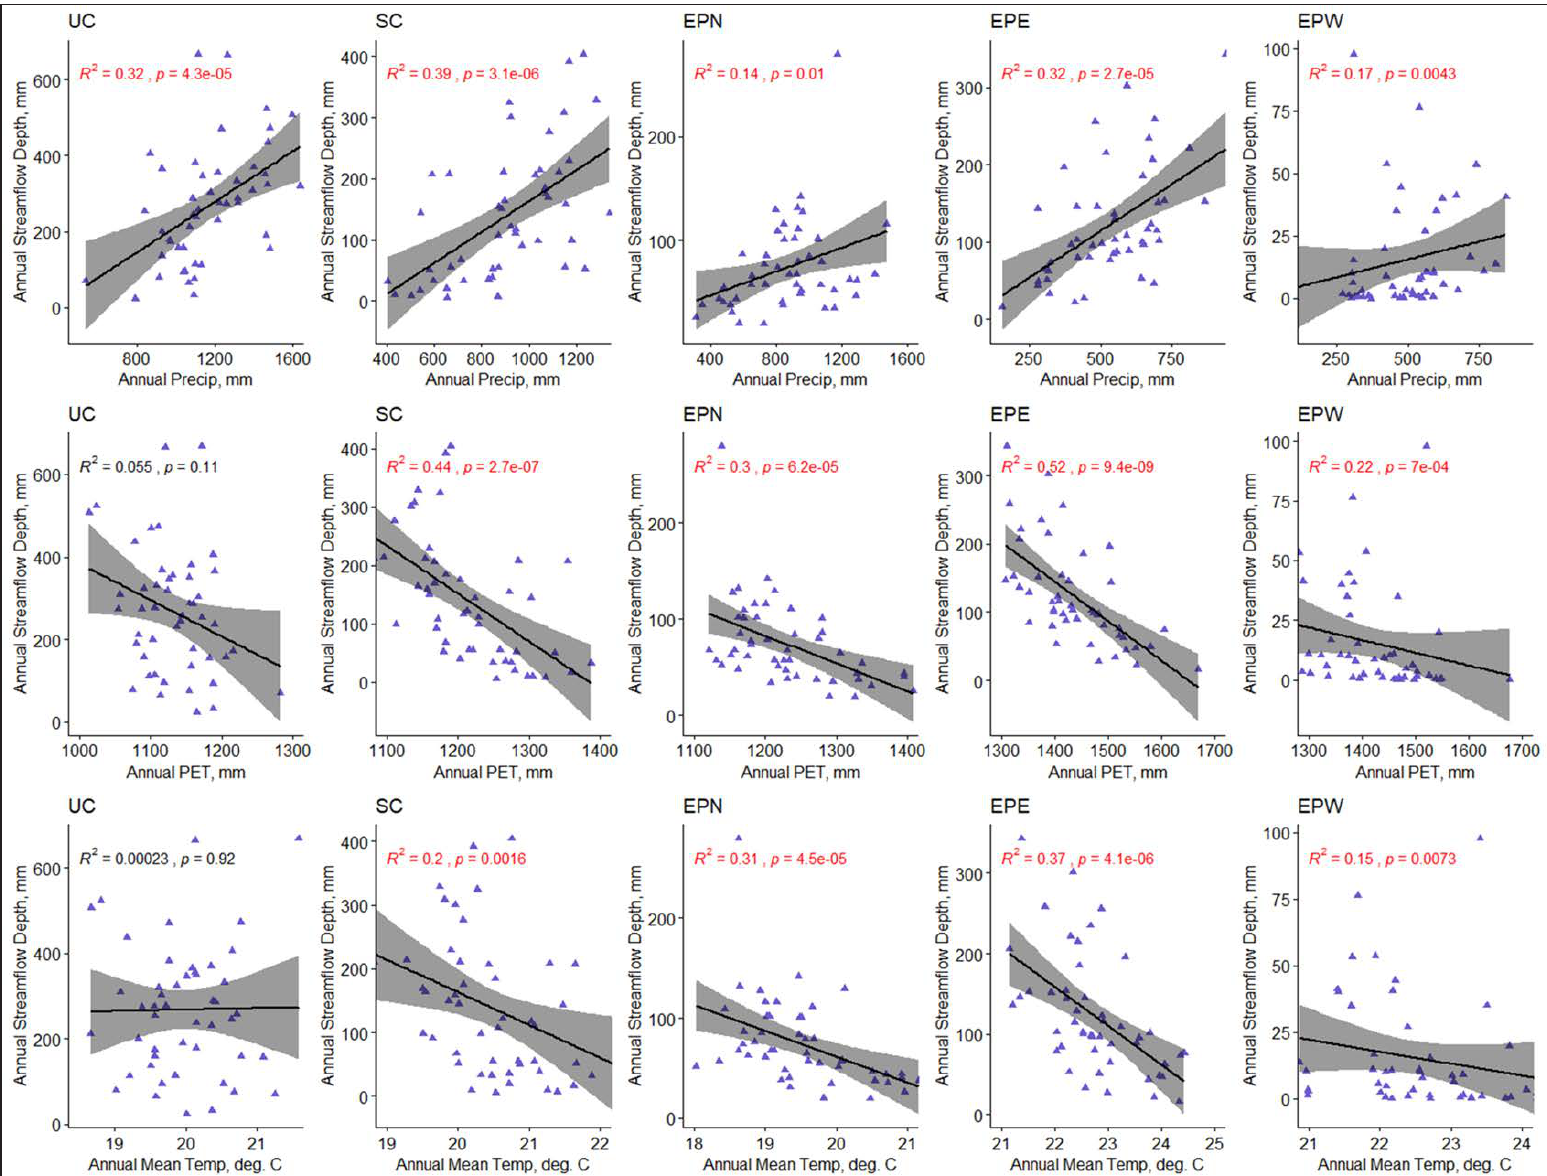
Figure 4. Spearman correlation between annual streamflow volume (expressed as depth) and CRU climate variables. The gray bands show the 90% confidence limits (coefficient of determination r 2 are shown in red where p≤0.05; gage 08195000 is used to represent the EPE